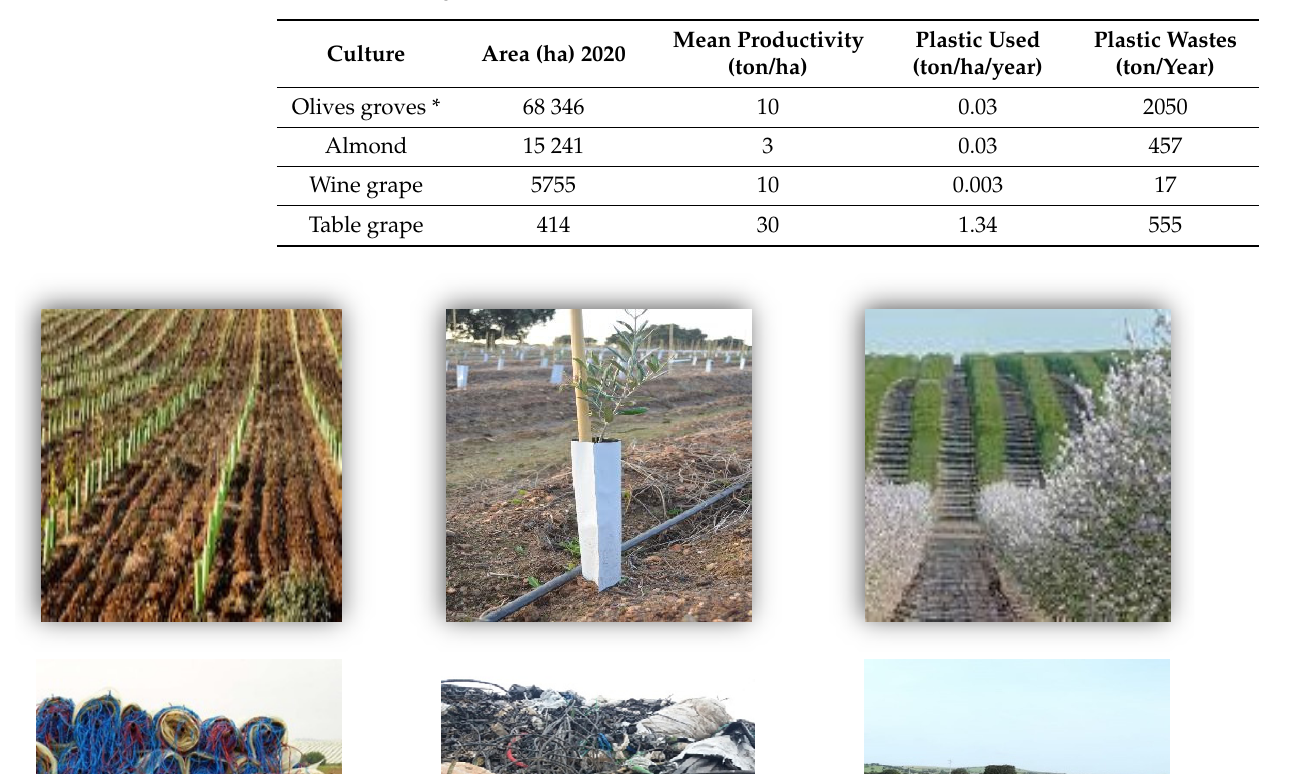
Table 1. Main cultures practice in the Alqueva Dam irrigation area. In Table 1, ha = 10,000 m 2 . * Intensive olive groves.